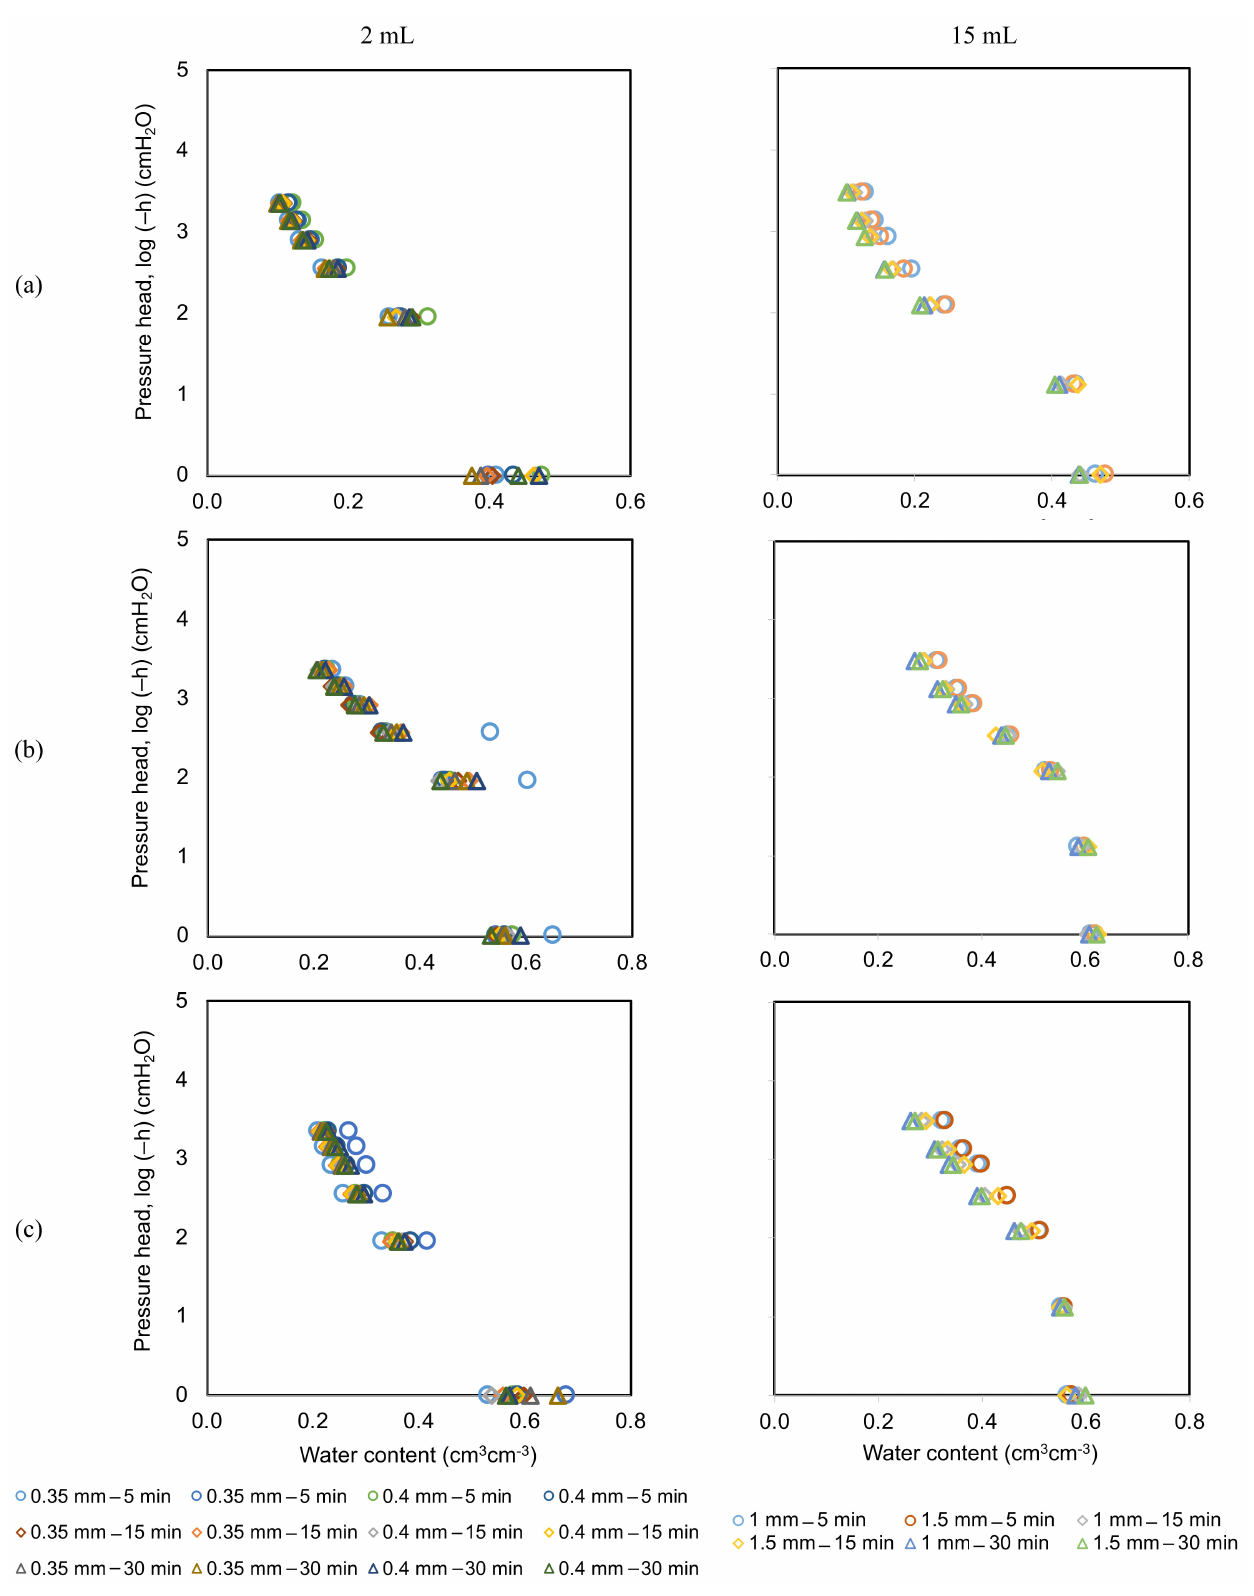
Figure 4. Experimental water content of 2 mL and 15 mL tubes ( a ) Decomposed granite soil (Masa soil); ( b ) Volcanic ash soil (Andisol soil); ( c ) Paddy soil